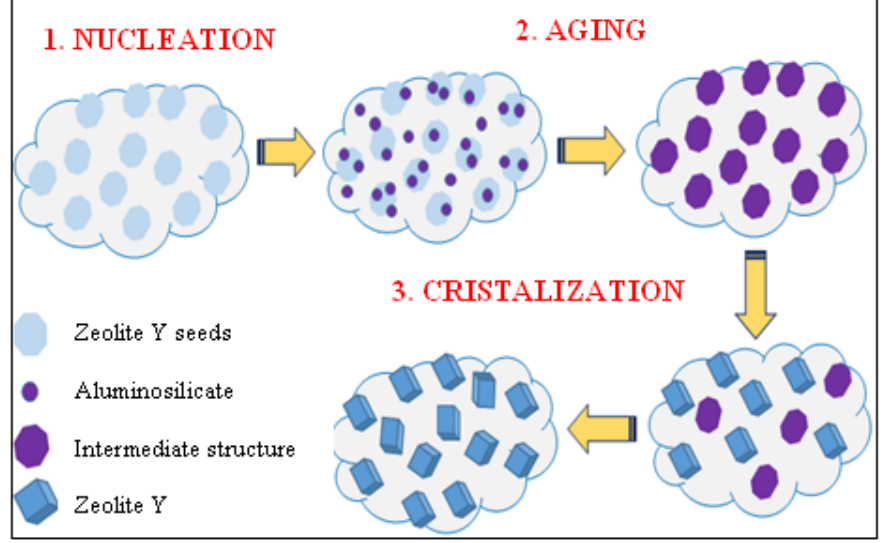
Figure 6. Graphical representation of the zeolitization process .